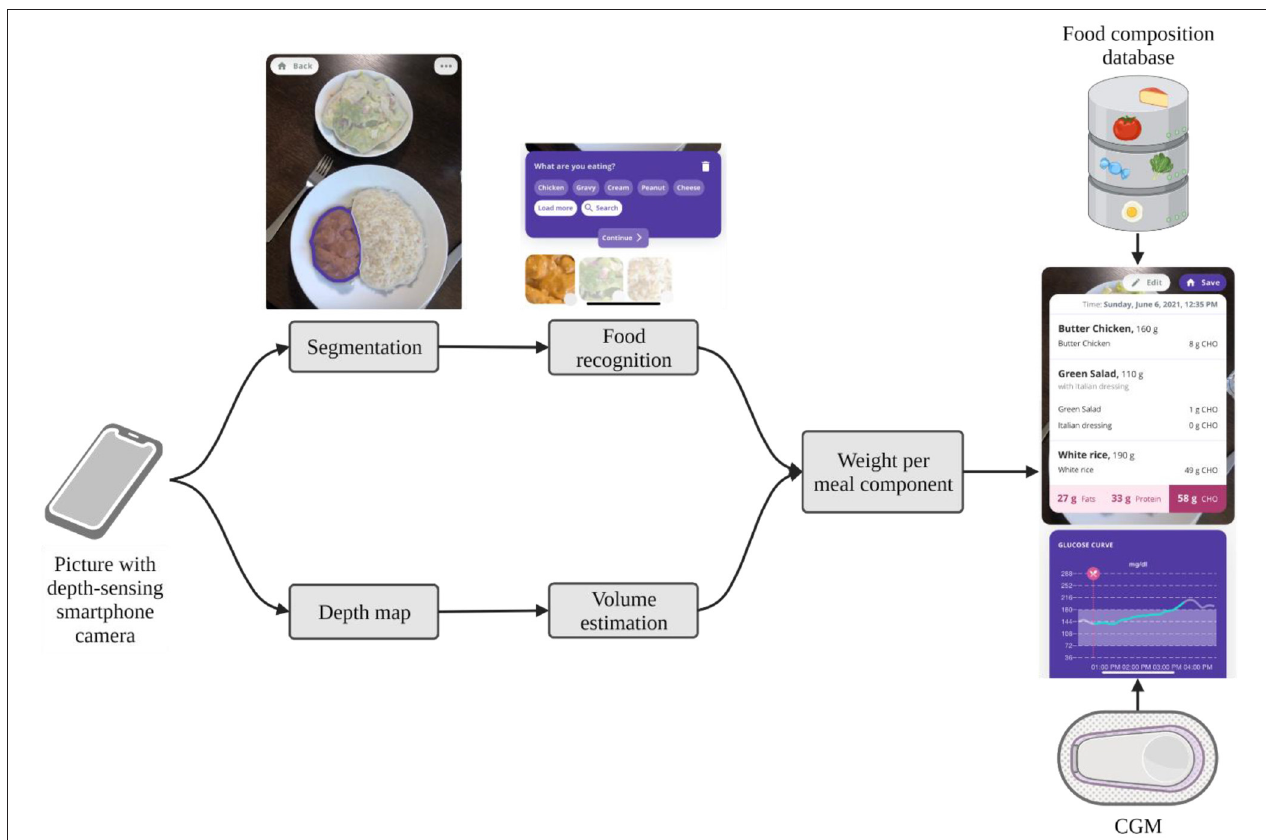
FIGURE 2 | Technical flow of the SNAQ app. The app automatically segments pictures of meals into meal components and recognizes the food of the components. If the picture is taken with a depth-sensing camera of newer smartphones, it creates a depth map to estimate the volume of each meal component. From the volume and the food recognition, it can calculate the weight of each meal component. By using a food composition database, the macronutrient composition of the meal is calculated and displayed to the user with the corresponding CGM data. Screenshots kindly provided by